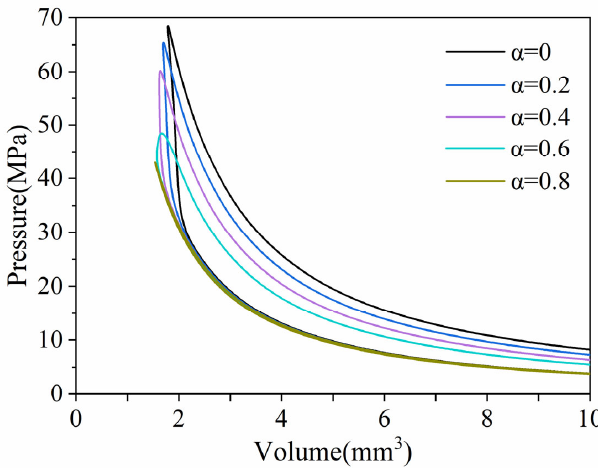
Figure 11. P-V diagram of the micro free-piston engine under different α .